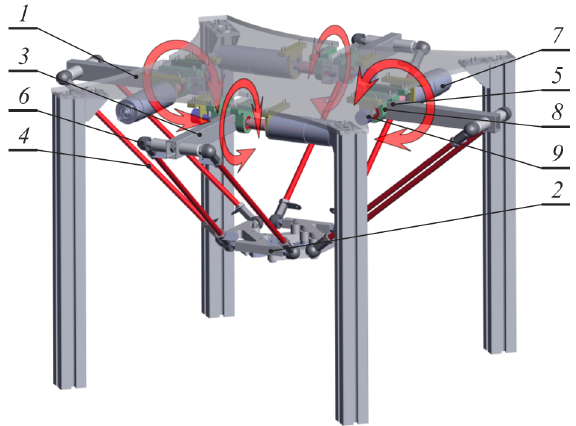
Figure 1. Solid model of delta 4-DoF parallel manipulator. 1—basis; 2—operating platform; 3—active arm; 4—passive arms; 5—rotating joint; 6—spherical joint; 7—drive (DC motor); 8—bearing bracket; 9—sensor of angular position.